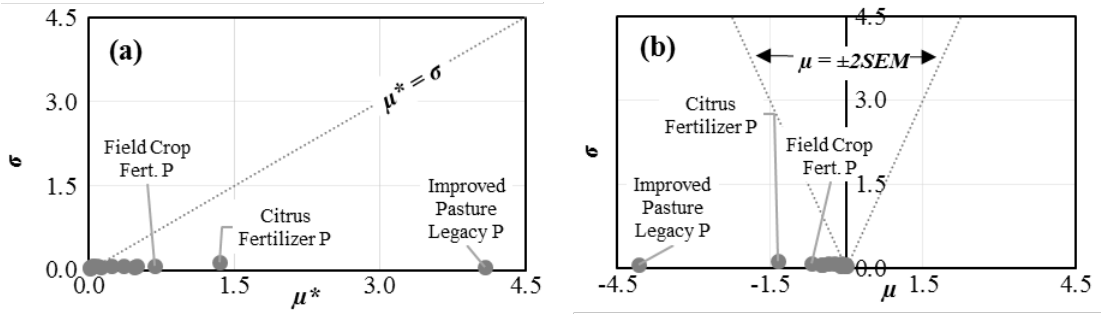
Figure 3. The Morris method Global Sensitivity Analysis results for the TCNS average annual TP loads, ( a ) µ* − σ space and ( b ) µ − σ space.